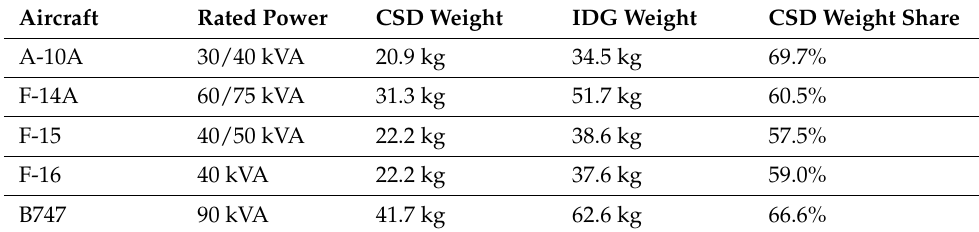
Table 2. IDG’s weight data comparison